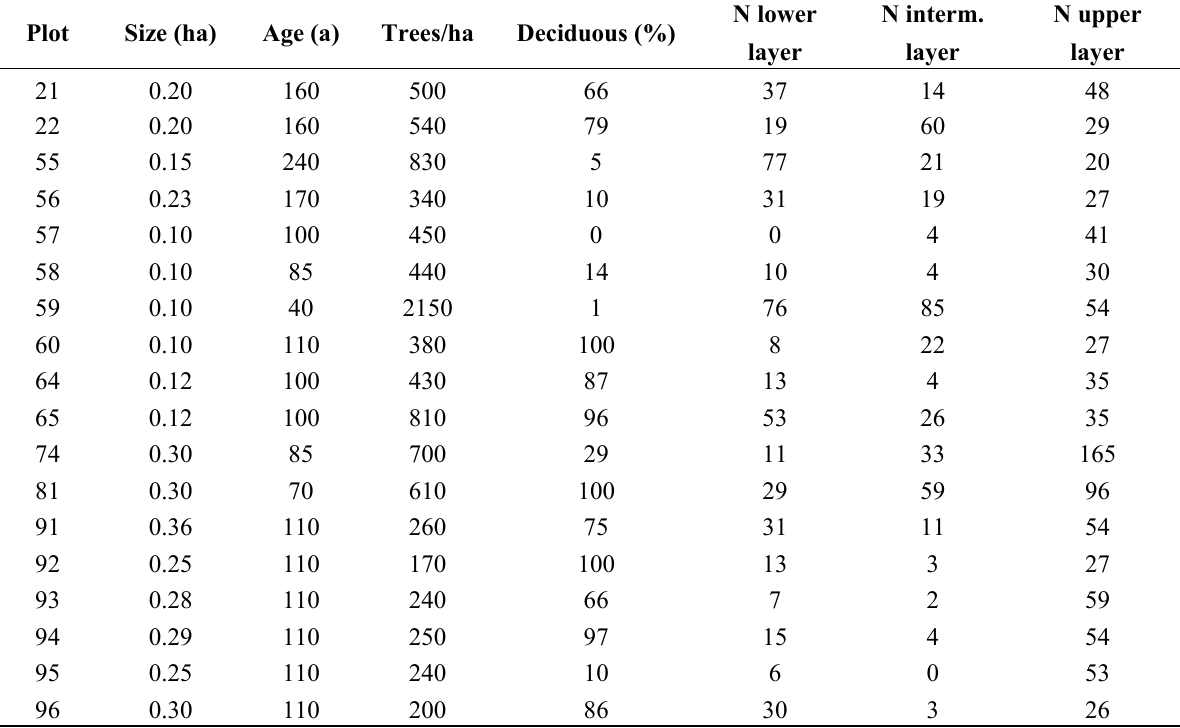
Table 1. Characteristics of sample plots in Test Site I; N stands for the number of trees.